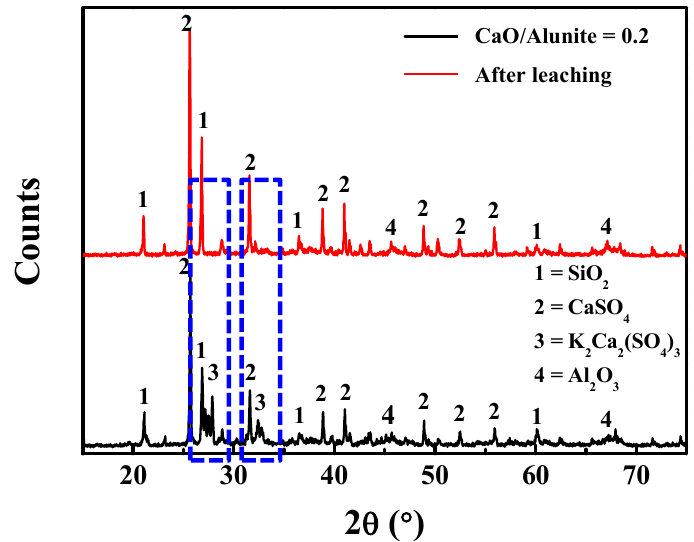
Figure 3. X-ray diffraction (XRD) patterns of the calcined products at 700 °C (CaO/alunite = 0.2) and leaching residual. Table 1. X-ray fluorescence (XRF) analysis of the crystallized product of lixivium from the calcined products (CaO/alunite = 0.2) (in oxide